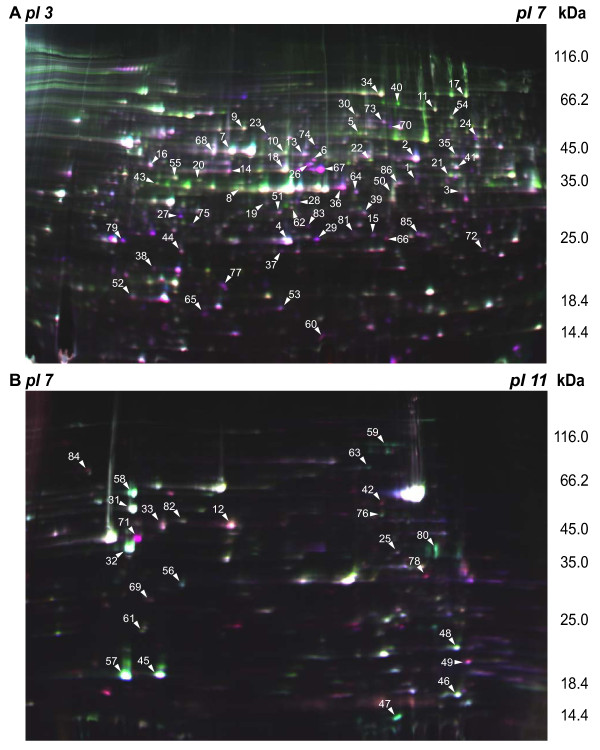
2D gel electrophoretic separation of protein extracts of A. fumigatus grown under normoxic and hypoxic growth conditions. In total, 86 different proteins of A. fumigatus changed significantly their abundance within the first 24 hours of hypoxia (protein spots are labeled with spot numbers as indicated in Additional file 3 and 5). A. fumigatus proteins were labeled with the CyDye DIGE Fluor minimal dye labeling kit. Subsequently, proteins were separated by 2D gel electrophoresis using immobilized pH gradient strips with a pH range of (A) 3-7 NL and (B) 7-11 NL in the first dimension. For the separation of proteins in the second dimension, SDS-polyacrylamide gradients gels (11-16%) were used. Differentially regulated proteins were identified by MALDI-TOF/TOF analysis. A three color overlaid gel image is shown. Samples were labeled as follows: 0 hour control sample (Cy5), 24 hour hypoxia sample (Cy3) and internal standard (Cy2).